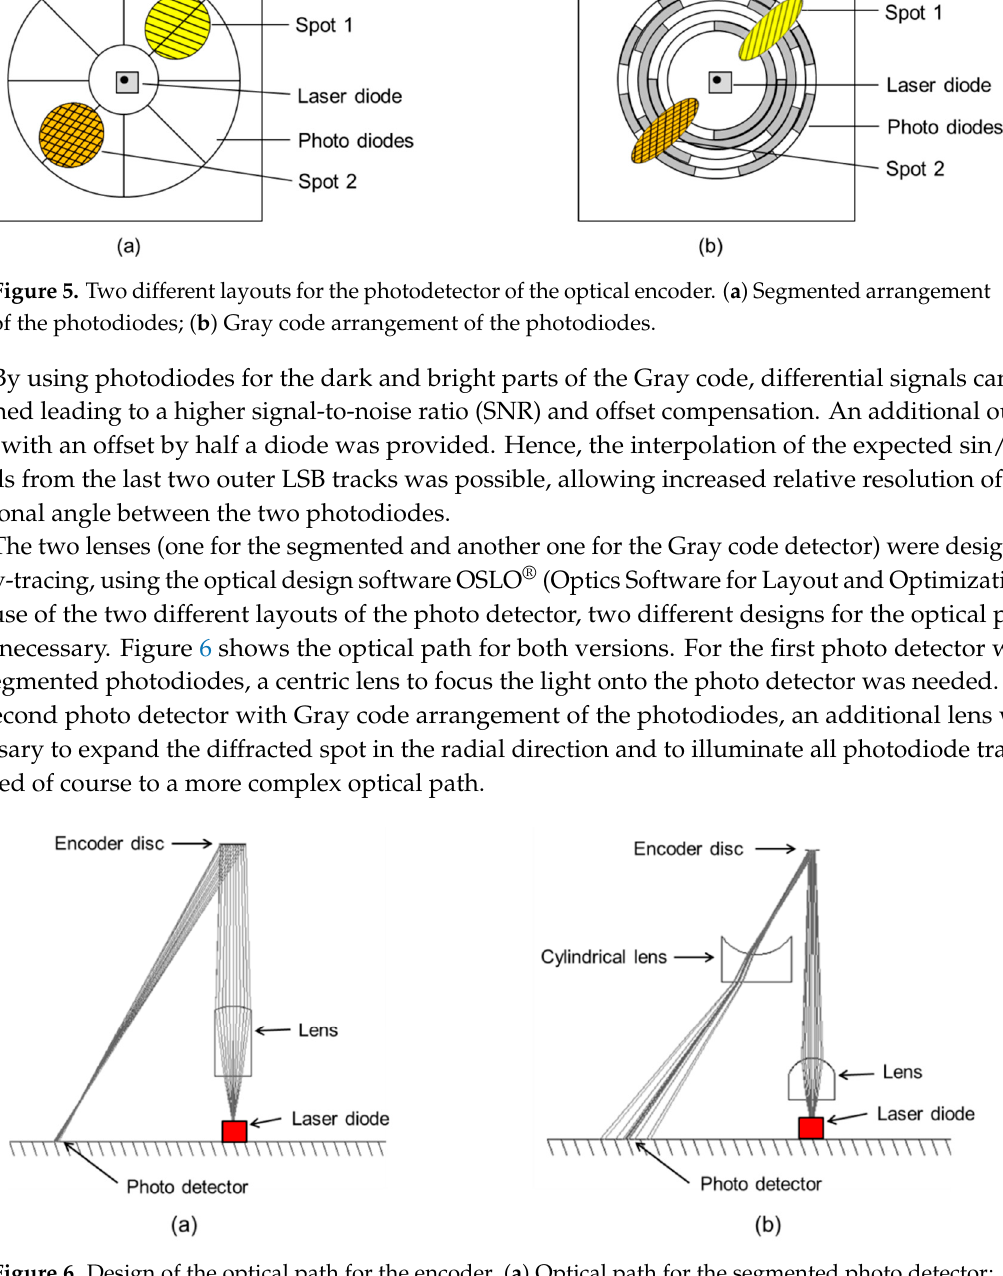
Figure 6. Design of the optical path for the encoder. ( a ) Optical path for the segmented photo detector; ( b ) optical path for the photo detector with Gray code arrangement of the photodiodes.